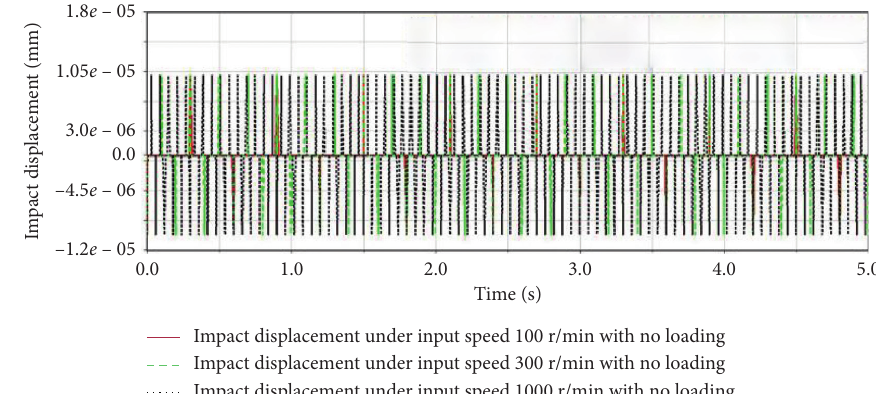
Figure 8: Impact elastic displacement of first-stage face gear pair with no loading.